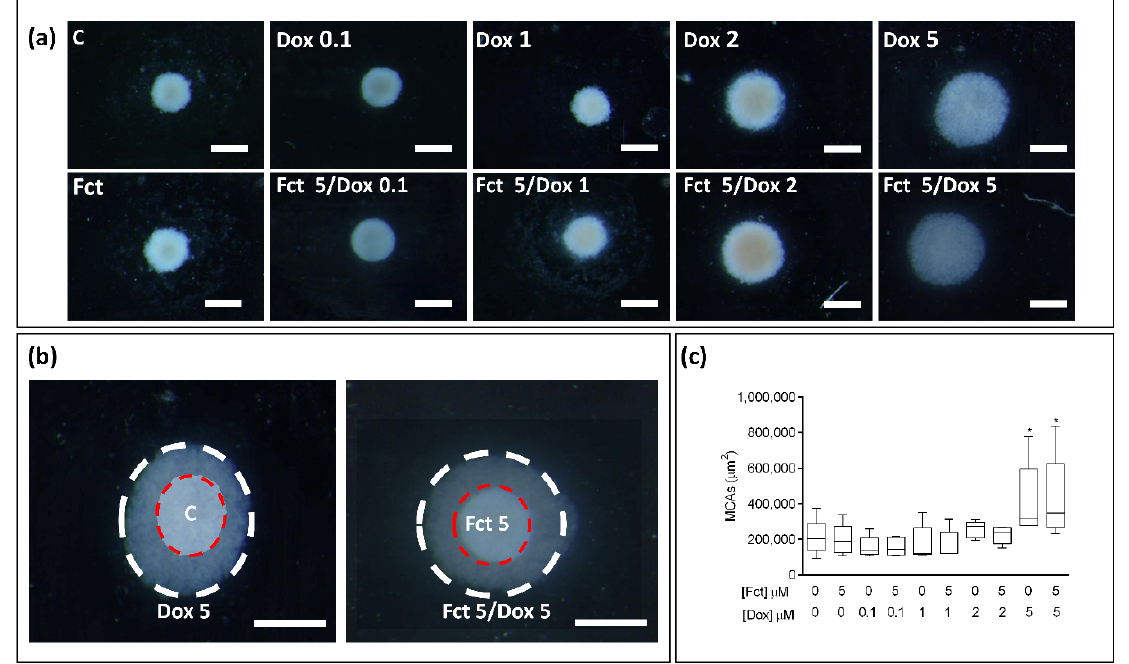
Figure 11. Representative stereomicroscopic images of 3D cultures-MCAs in the tested conditions of fucosterol (Fct) at 5 μ M alone, and in combination with doxorubicin (Dox) at 0.1, 1, 2, and 5 μ M. Cells treated with 0.1% DMSO (C) and Dox (5 μ M) were included as negative and positive controls, respectively ( a ). Two images of MCAs from C and Fct (5 μ M) (red dashed circle) and Dox (5 μ M) and Fct (5 μ M) + Dox (5 μ M) (white dashed circle) are overlapped to show the difference in cellular aggregation between the two tested conditions ( b ). Box and whisker graph of Areas of MCAs expressed as median, maximum, minimum, and interquartile range (Q3-Q1 of five independent experiments (16 MCAs/per tested condition/per experiment) ( c ). Significant differences: * p < 0.05. Scale bar: 500 μ m.